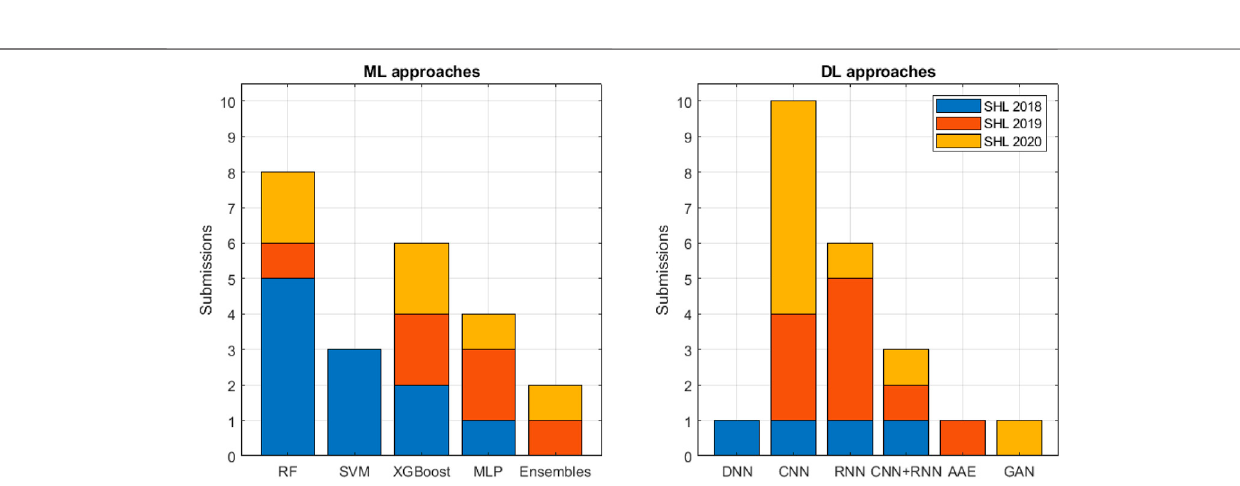
Frontiers in Computer Science |